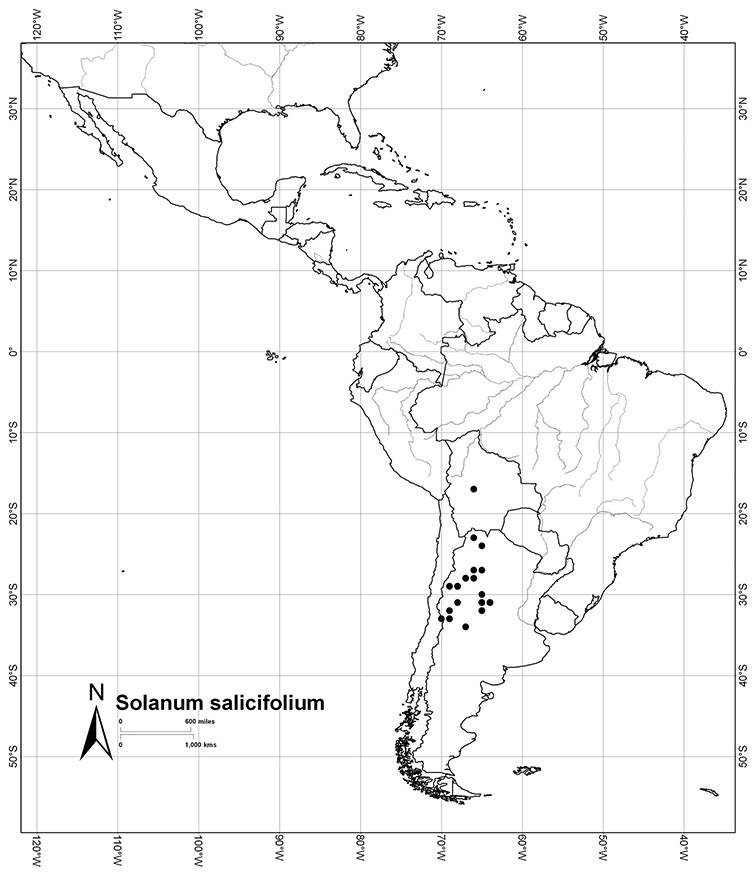
Distribution of Solanum salicifolium Phil.